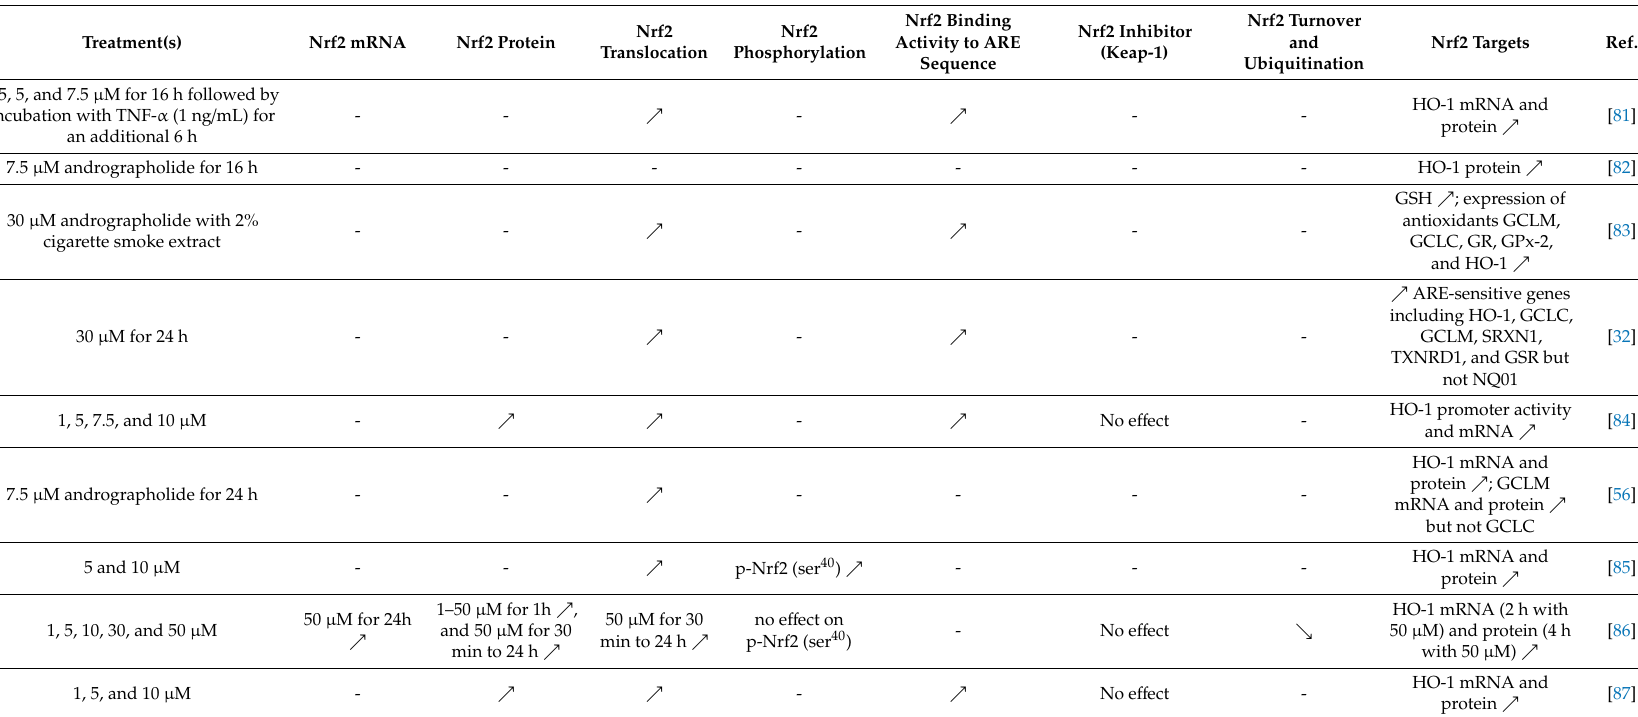
Table 1. Main e ff ects of andrographolide on Nrf2 (nuclear factor (erythroid-derived 2)-like 2) pathway in vitro. Symbols: “ (cid:37) ” for an increase, “ (cid:38) ” for a decrease, and “-” for not communicated. ARE: antioxidant response element, Keap-1: Kelch-like ECH-associated protein 1, GSH: reduced glutathione, NOX: NADPH oxidase, SOD: superoxide dismutase, CAT: catalase. Treatment(s) Nrf2 mRNA Nrf2 Protein